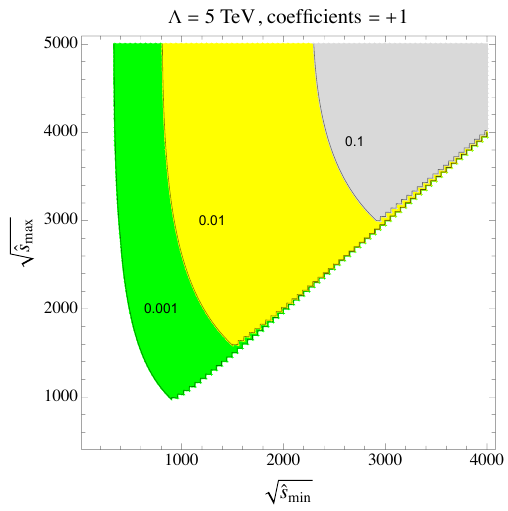
Figure 4 . Absolute value of the ratio of the O (1 / Λ 6 ) contributions relative to the SMEFT cross √ section to O (1 / Λ 4 ) as a function of the minimum center of mass energy ˆ s and the maximum min √ ˆ s , | ( σ ( pp → ‘ + ν ) ) /σ ( pp → ‘ + ν ) − σ ( pp → ‘ + ν ) | ). All Wilson max O (1 / Λ 6 ) large ˆ s O (1 / Λ 4 ) O (1 / Λ 4 ) coefficients are taken to be positive and equal to one, and the new physics scale Λ = 5